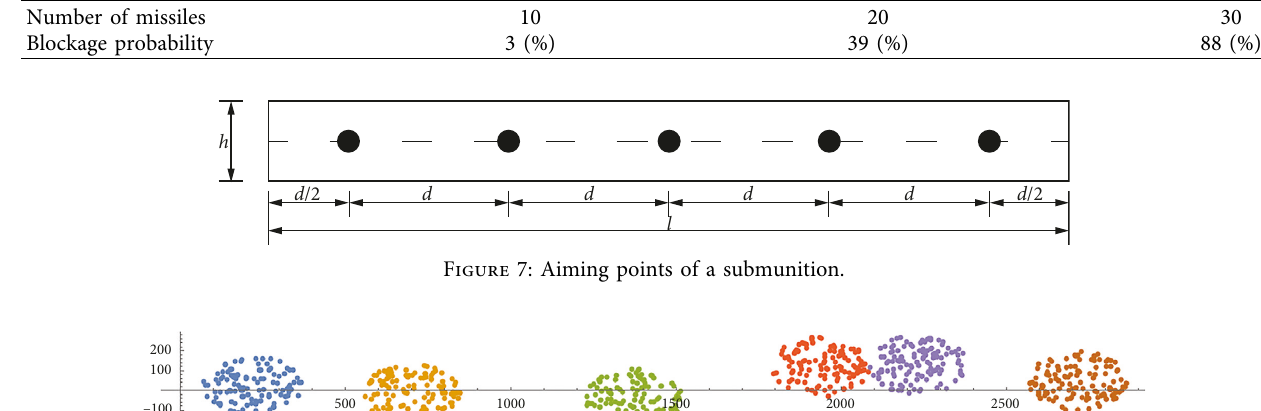
Table 3: Simulation